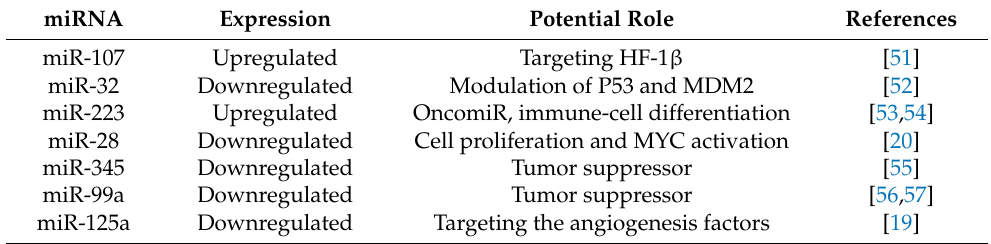
Table 1. The potential role of exosomal miRNAs in the transition from MGUS to SMM [18]. miRNA Expression Potential